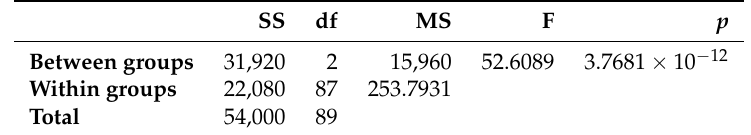
Figure 8. Task 5-text input using three different haptic technologies: ( a ) distribution per treatment, ( b ) mean and standard deviation, ( c ) evaluation function of users’ age. Table 7. Kruskal Wallis test for Task5.